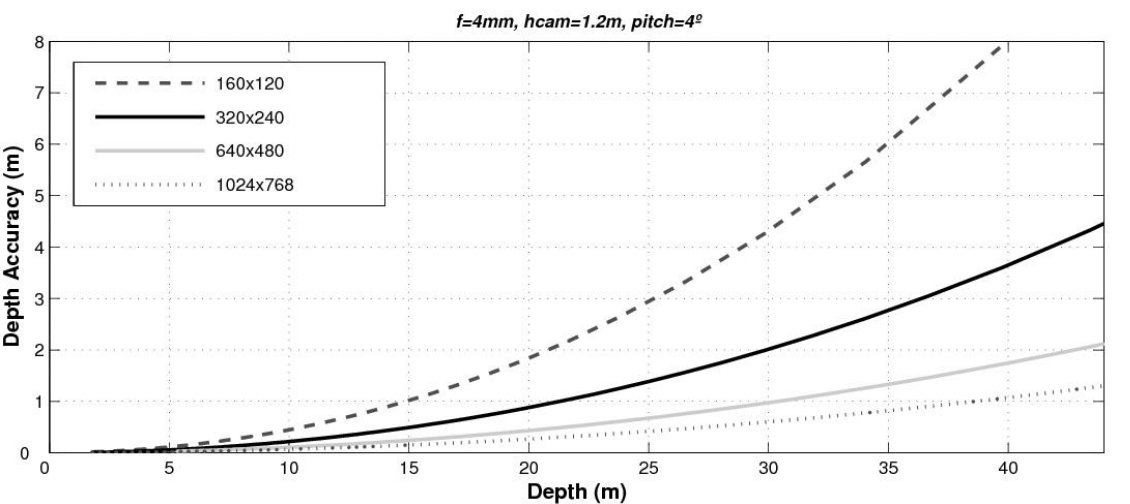
Figure 14. Accuracy of the host-to-vehicle distance obtained by using different images